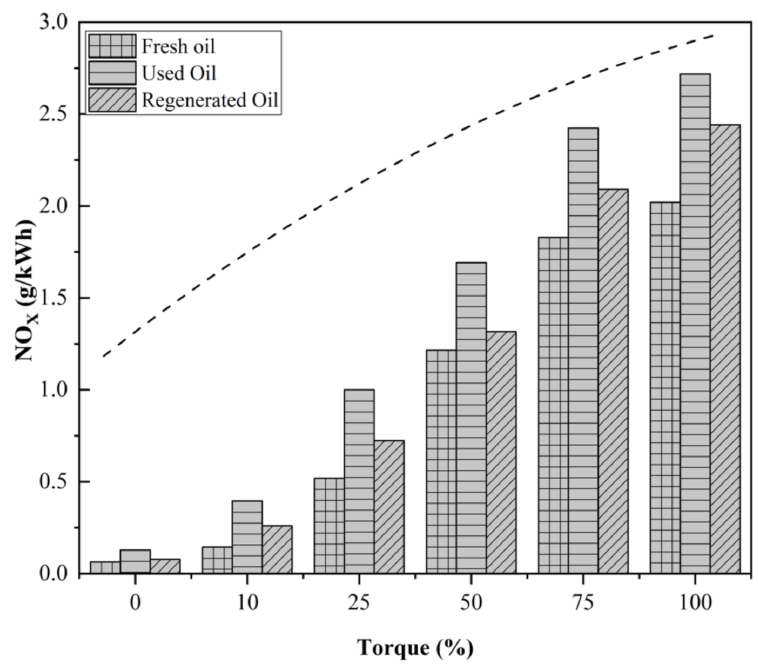
Figure 10. NO x emissions variations with torque